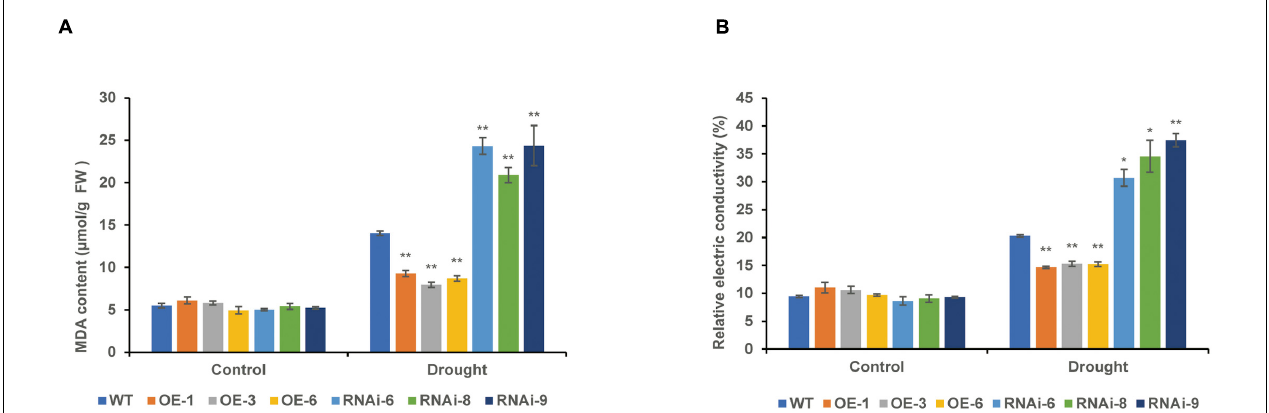
FIGURE 7 | Effect of drought stress on the malondialdehyde and relative electrical conductivity of WT and transgenic wheat. (A) Malondialdehyde content of 4 weeks WT and TaNRX1 transgenic wheat in normal water supply and 10 days of drought stress ( n = 4). (B) Relative electrical conductivity ( n = 4). Data represent the mean ± SD. WT, wild type; OE-1–OE-6, TaNRX1 overexpression T 3 homogeneous lines; RNAi-6–RNAi-9, TaNRX1 RNA interference T 3 homogeneous lines. * P < 0.05, ** P < 0.01 represent the significant difference between the transgenic line and the WT, respectively.